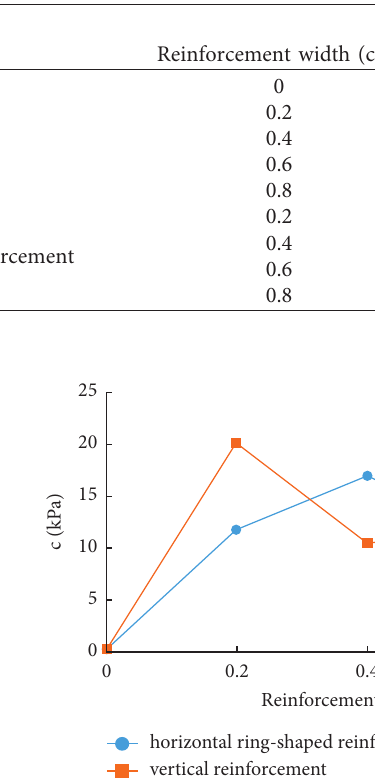
Figure 18: Relationship curves of the cohesive strength of reinforced sand and reinforcement